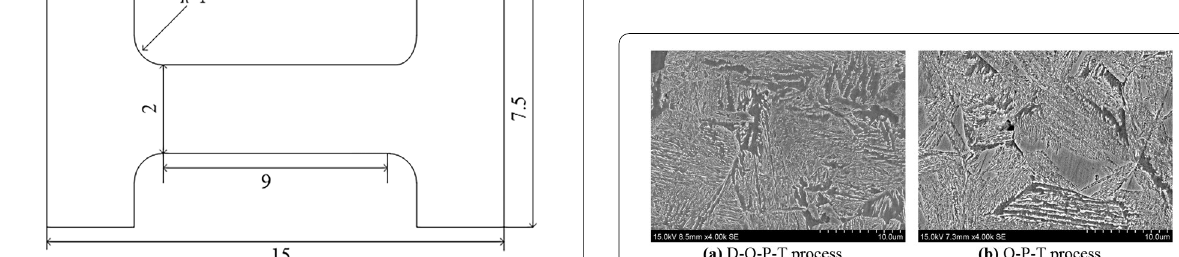
Figure 7 Dimension of the tension sample (mm)